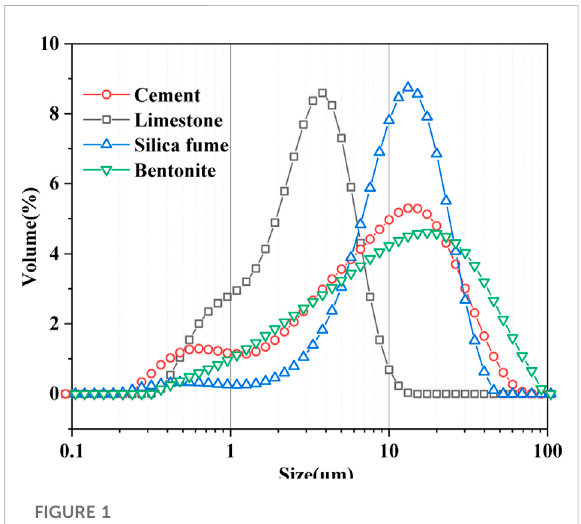
FIGURE 1 Particle size distributions of